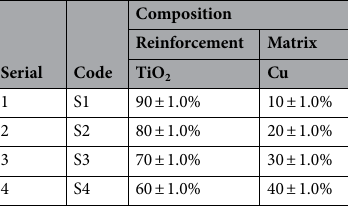
Table 1. Representative the composition and nomenclature of prepared specimens.